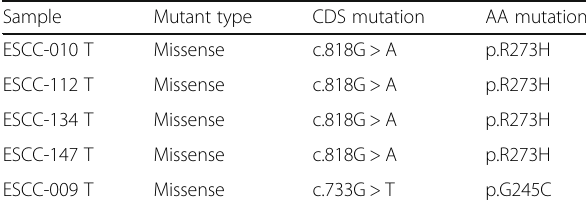
Table 2 TP53 mutation sites in 88 WGS ESCC samples